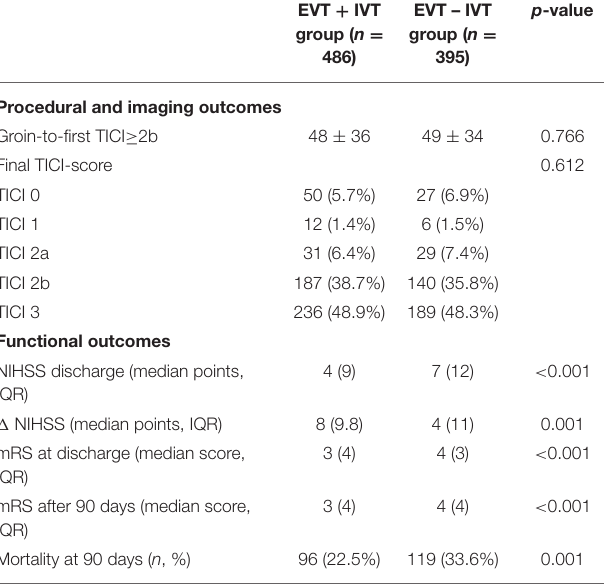
TABLE 2 | Unadjusted primary outcome parameter in patients with and without bridging-thrombolysis.